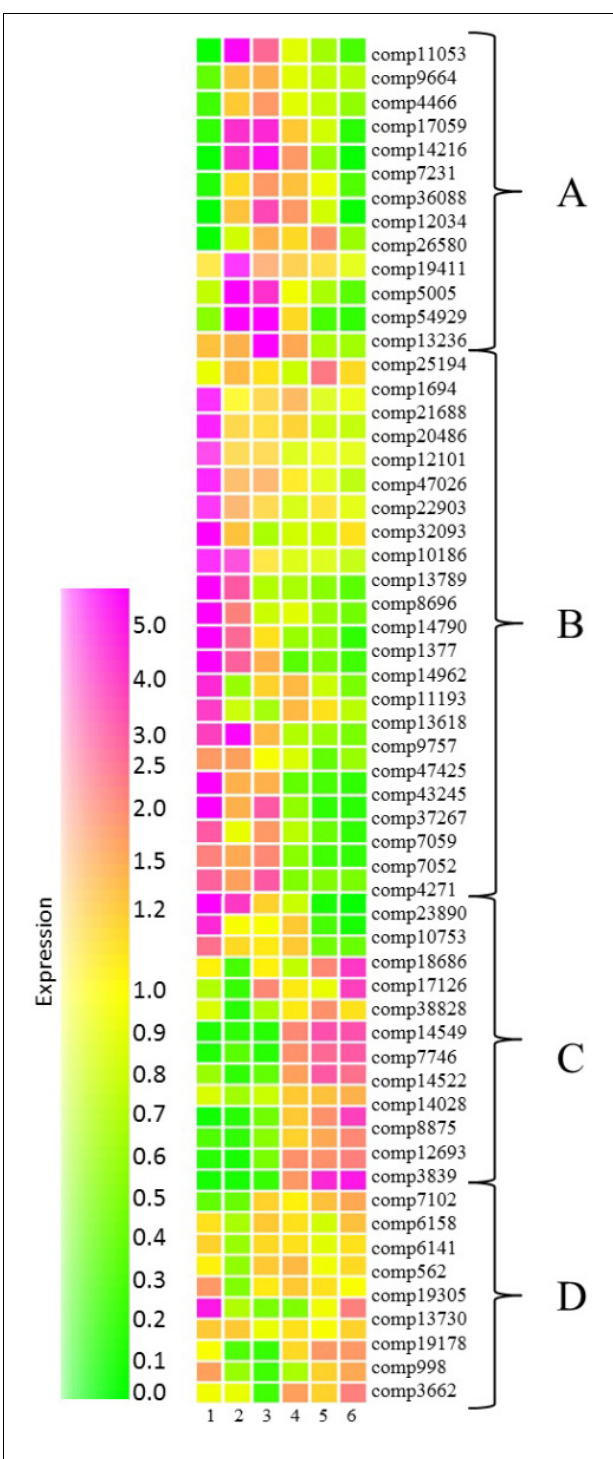
FIGURE 6 | Relative abundance of transcripts encoding putative transcription factors at six stages of blackcurrant fruit development. Transcript levels are expressed relative to the median level of the transcript across all 18 arrays according to the scale indicated. Clusters of transcripts most abundant at mid-fruit development (A) , early fruit development (B) , late fruit development (C) , and both early and late fruit development (D) are indicated. Transcripts are identified by their contig reference as indicated to the right of each